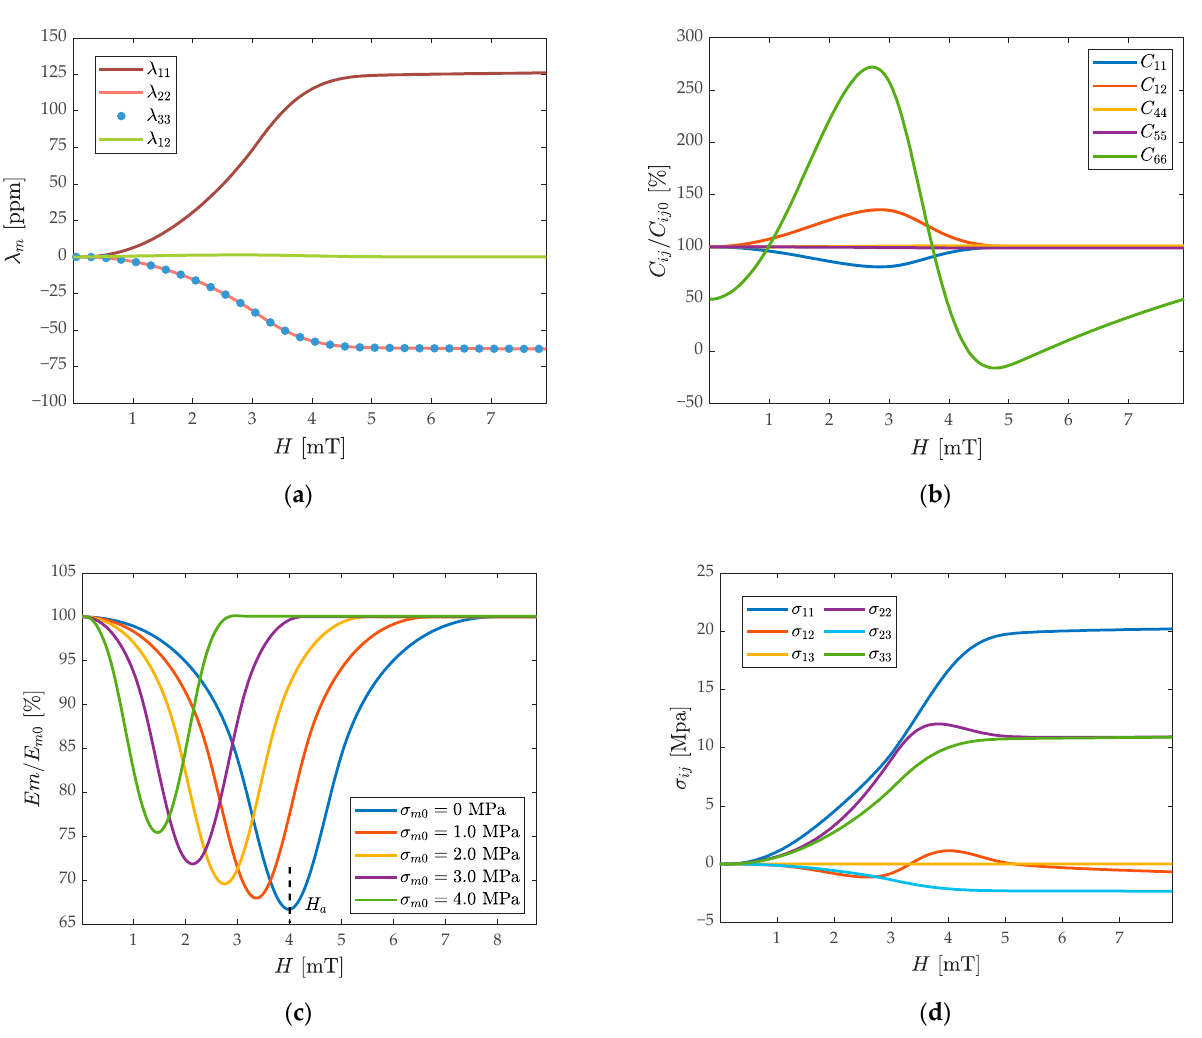
Figure 2. Magnetoelasticity properties of the ∆ E-effect: ( a ) the modeled variation of magnetostrictive strain components as functions of the external applied magnetic field H ; ( b ) the relative changes of key components of the magnetostrictive material stiffness tensor; ( c ) under the different axial tensile initial stress, the relationship between the normalized Young’s modulus and magnetic field in the magnetostrictive film. When the anisotropic magnetic field H a is reached, E m has a minimum value; ( d ) the dependence of magnetostrictive stress tensor components on the external magnetic field.